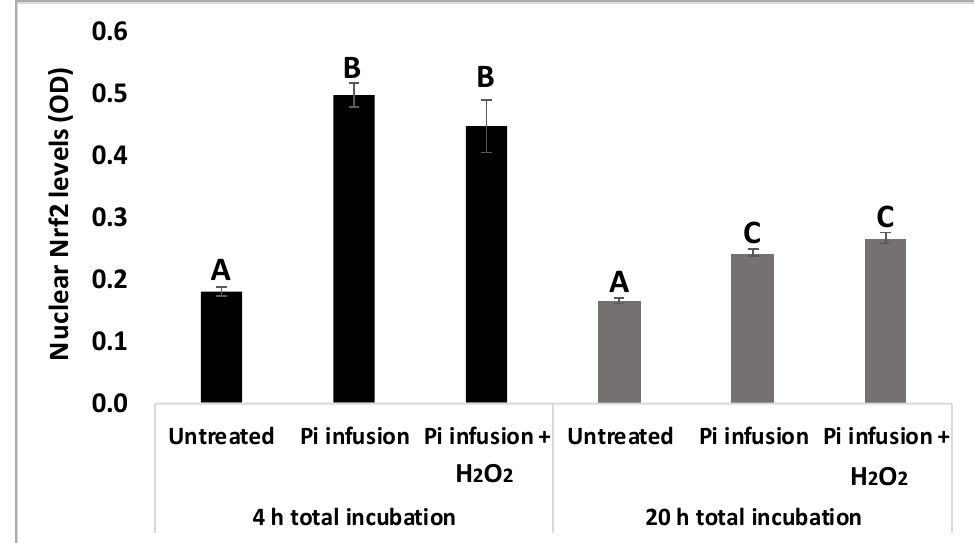
Figure 6. Pi infusion enhances Nrf2 expression levels in the nucleus of neuronal cells. SH-SY5Y cells were pretreated with Pi infusion (200 µg/mL) for 2 h or 18 h, and then incubated for an additional 2 h with H 2 O 2 (200 µM). Nrf2 levels in the nucleus were then determined. The results are from a representative experiment out of two independent experiments, with each experiment conducted in duplicates. The results are presented as mean ± SEM ( n = 4) and were analyzed by one-way ANOVA followed by the Tukey – Kramer multiple comparison test. Columns marked with different letters (A, B, C) represent statistically significant differences ( p < 0.05).